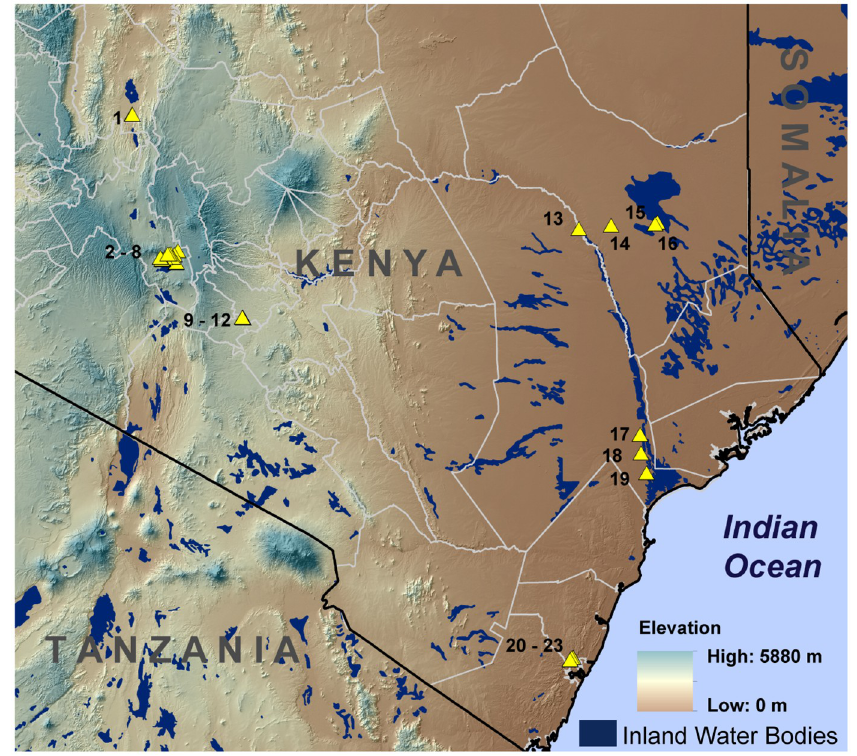
Fig 1. Sample site locations and elevation in study